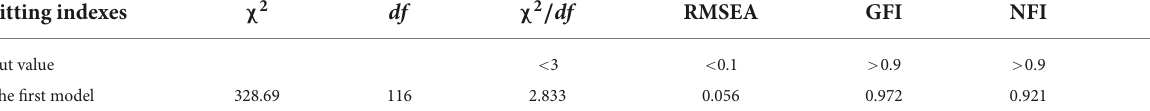
TABLE 3 Model fit indices.